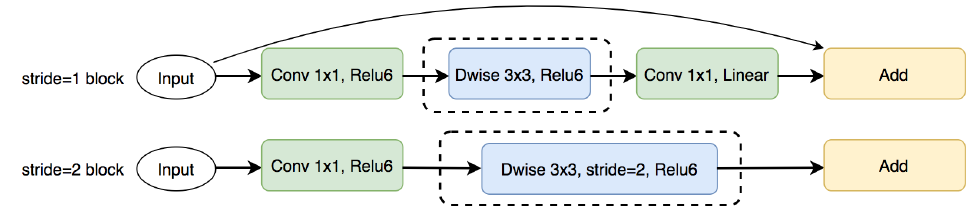
Figure 4. Illustration of MobileNet-V2 network architecture.